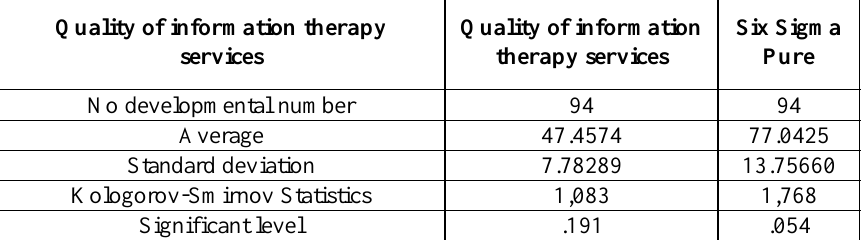
Table 1. Kolmogorov - Smirnov